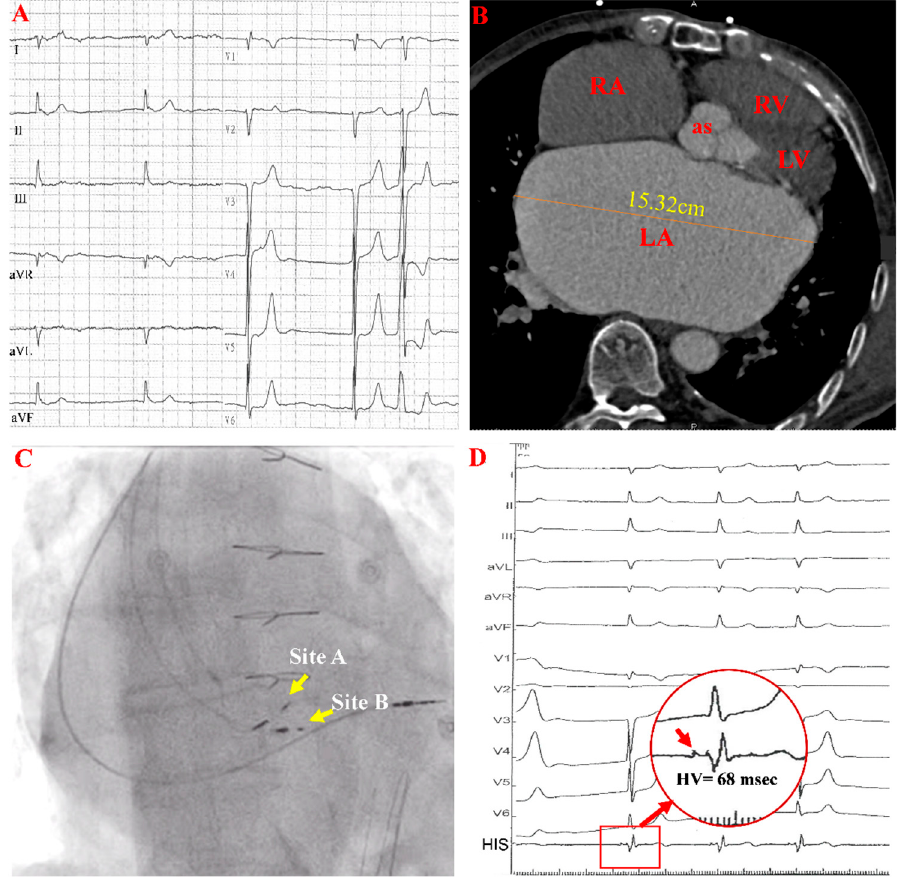
Figure 1. Images and ECGs before HBP. ( A , B ) show a preprocedural ECG and large left atrium in cardiac CTA. ( C , D ) are fluoroscopic AP views and electrograms with prolonged HV intervals during the procedure. In panel ( D ), the red arrow in the red circle indicates the HB potential. AP: anteroposterior projection; RA: right atrium; LA: left atrium; RV: right ventricle; LV: left ventricle; as: aortic sinus.